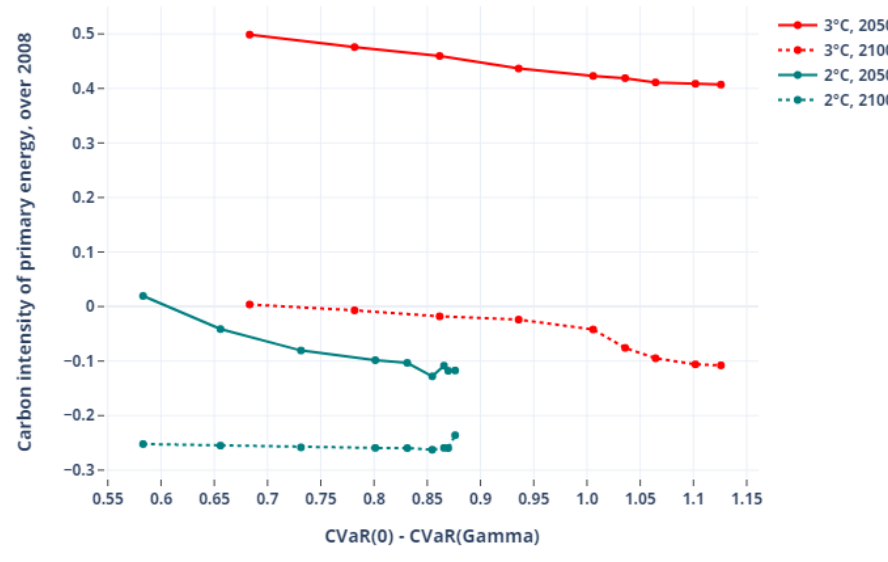
Figure 7. Carbon intensity of primary energy against protection